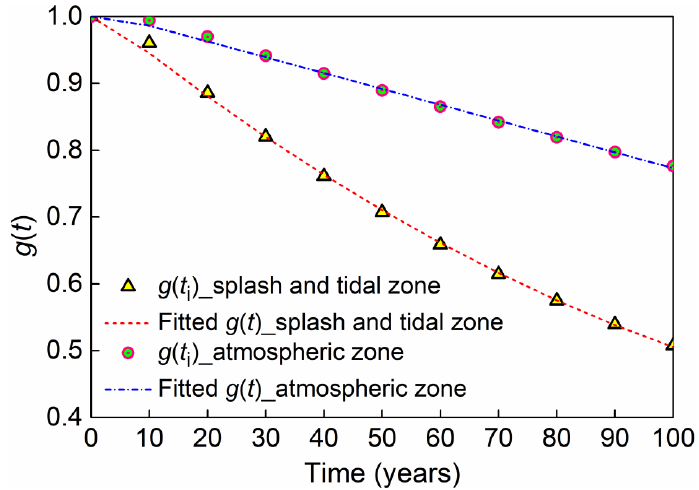
Figure 12. Moment resistance reduction